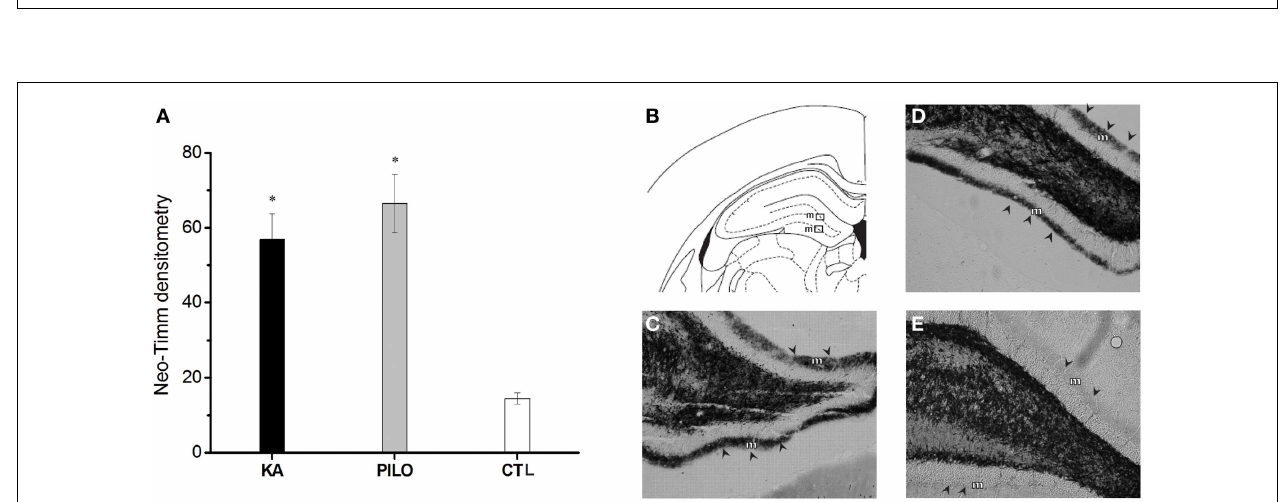
FIGURE 3 | Hippocampal histological analysis of Nissl-stained sections (number of cells × 1000) .The number of hilar (A) is stable over the time for all groups. Differences in the number of cells are reported by comparing both experimental groups with their age-matched controls (*) or between both experimental groups ( # ).The number of granule cells (B) is reduced in both models (* P < 0.05).Three months after status the number of pyramidal CA1 (C) and CA3 cells (D) was similar between KA and PILO groups, both being reduced when compared with CTL (* P < 0.01). Six months after status, the